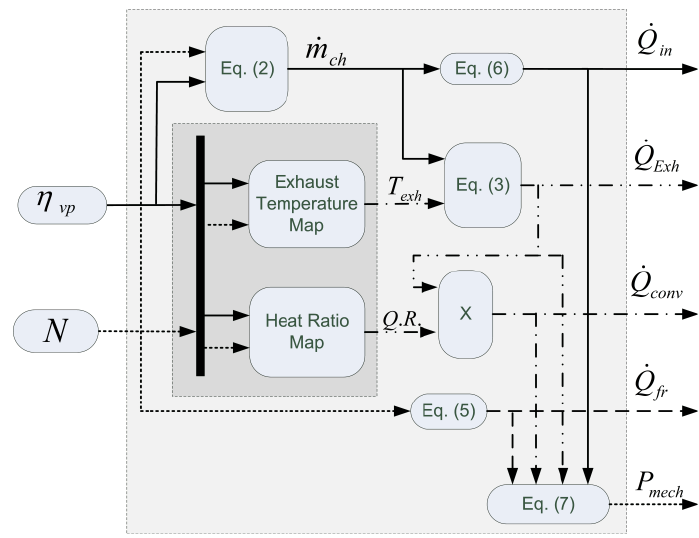
Figure 2. Block diagram of the power component calculator subsystem.